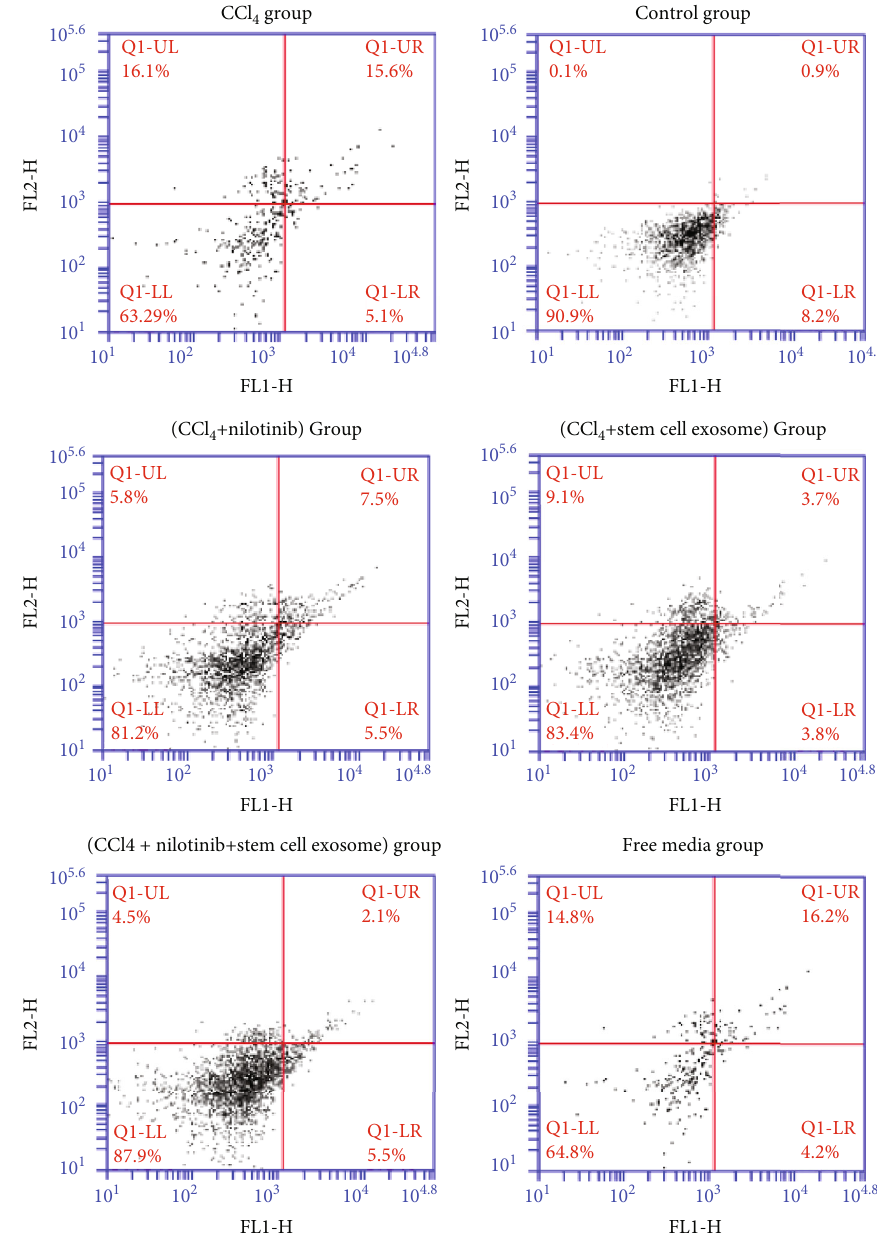
Figure 1: Annexin V apoptotic marker among the studied